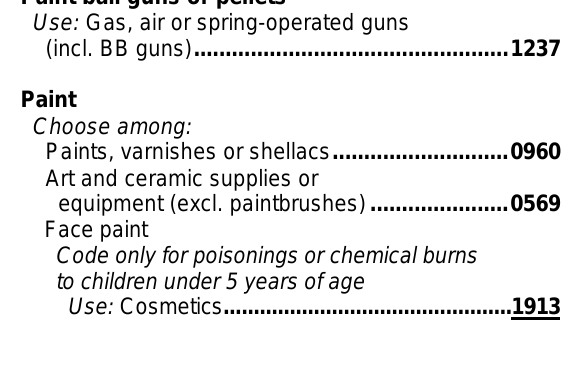
Paddle ball Use: Squash, racquet ball or paddle ball